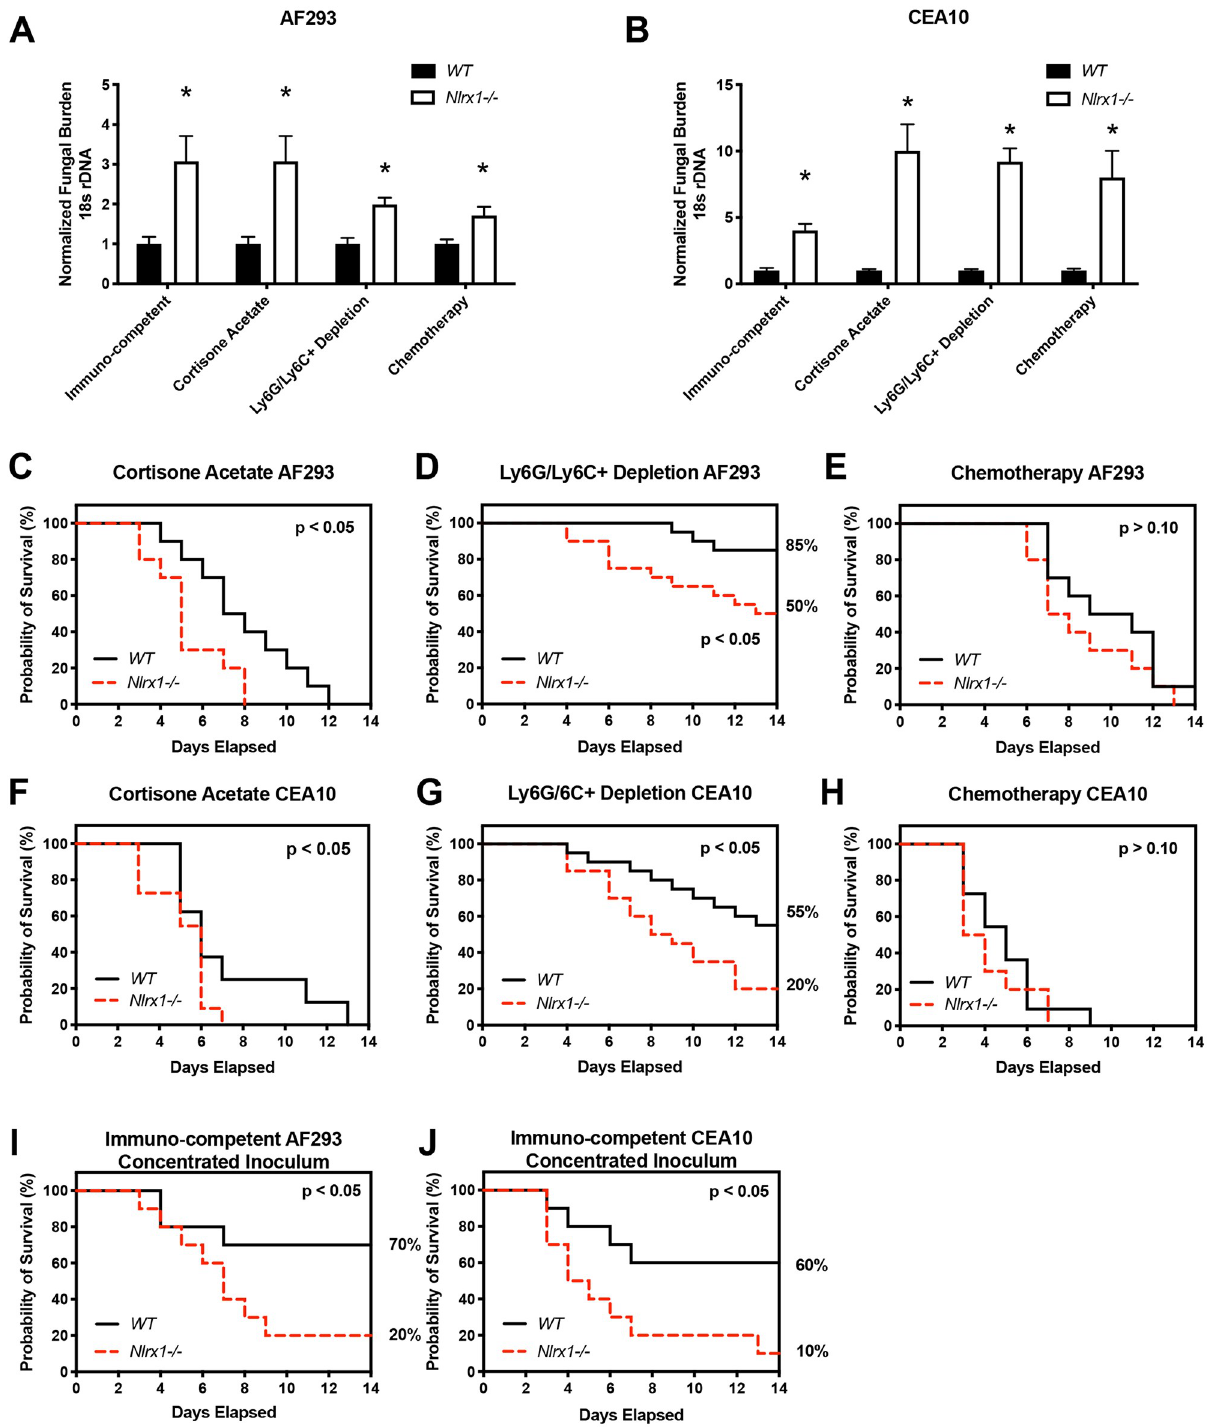
Fig 1. Measurement of fungal burden and survival during mouse models of invasive pulmonary aspergillosis. Freshly harvested conidia from either the AF293 or CEA10 isolate were delivered via aerosolization (12 mL, 1 X 10 9 conidia/mL) to wild type and Nlrx1-/- mice under immuno-competent or immuno-suppressive conditions including antibody based induction of neutropenia (Ly6G/Ly6C+ depletion), cortisone acetate treatment, and chemically induced leukopenia (Chemotherapy). Normalized fungal burden from mice that were humanely euthanized on day 3 post inoculation with either the (A) AF293 isolate or (B) CEA10 isolate. Kaplan-Meier survival curve of wild type and Nlrx1-/- mice aerosol inoculated with either the (CDEI) AF293 or (FGHJ) CEA10 isolate of A . fumigatus in various immune suppressive states. Kaplan-Meier survival curve of wild type and Nlrx1-/- mice